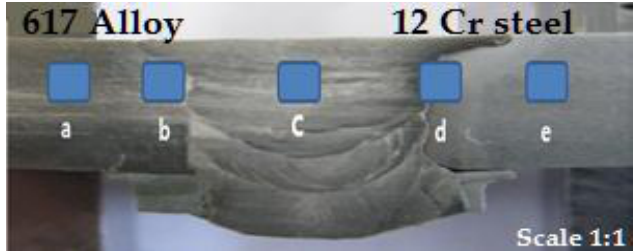
Figure 8. Positions of microstructure analysis for the dissimilar material welded joint.